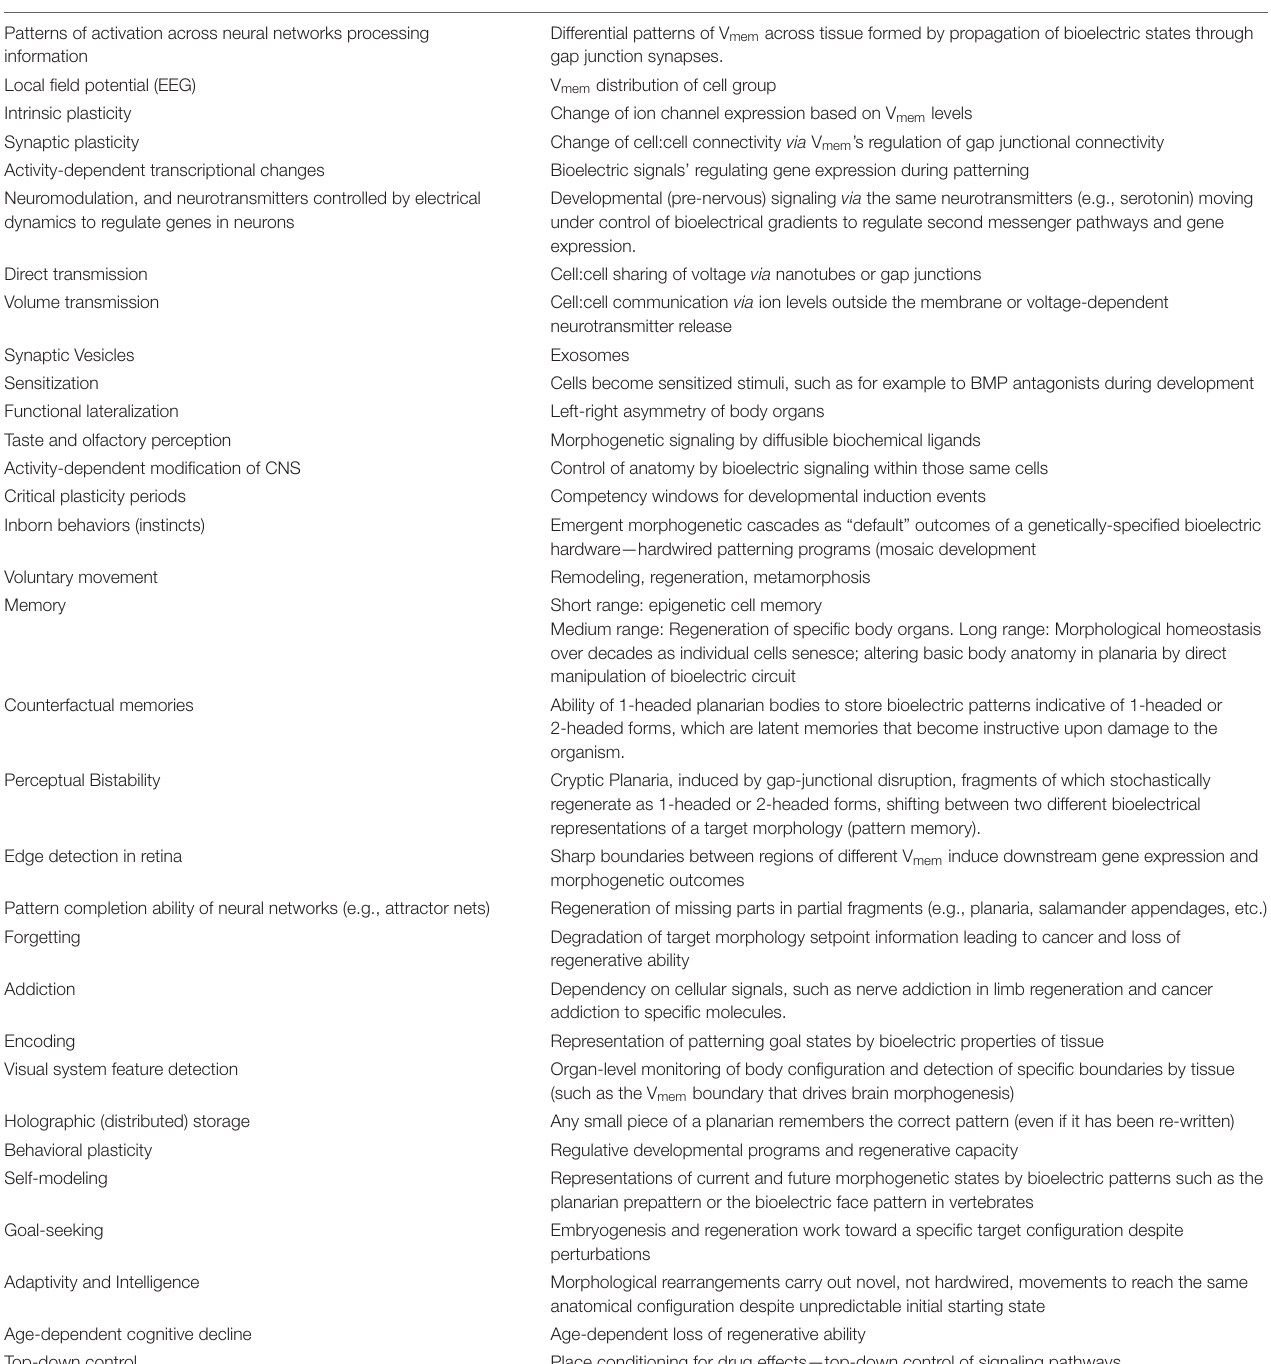
TABLE 2 | isomorphism between cognition and pattern formation. Cognitive concept Morphogenetic